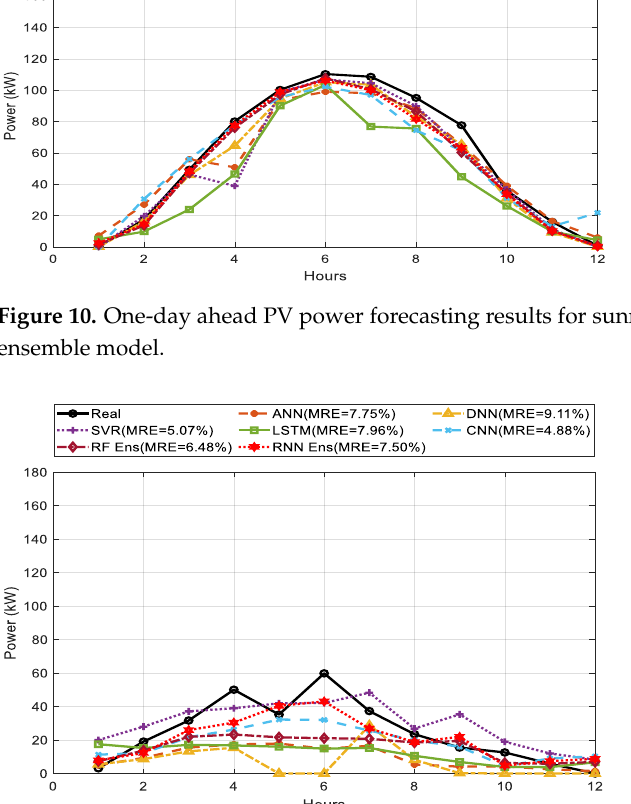
Figure 11. One-day ahead PV power forecasting results for cloudy days between single model and Figure 12. One-day ahead PV power forecasting results for rainy days between single model and Figure 12. One-day ahead PV power forecasting results for rainy days between single model and Figure 12. One-day ahead PV power forecasting results for rainy days between single model and ensemble ensemble model. ensemble model. ensemble model.